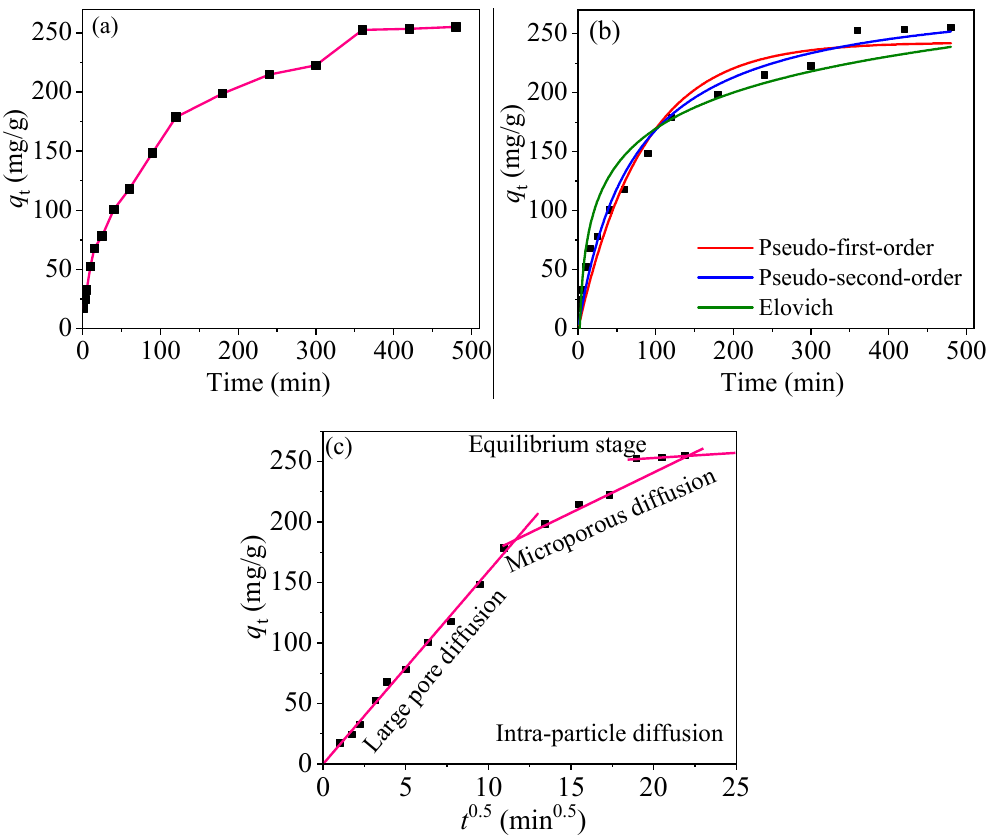
Figure 11. ( a ) Adsorption capacity vs. contact time; Kinetic fitting results: ( b ) and ( c ). Table 2. Kinetic fitting for adsorption of Hg 2 + onto PPy-Fe 3 O 4 /